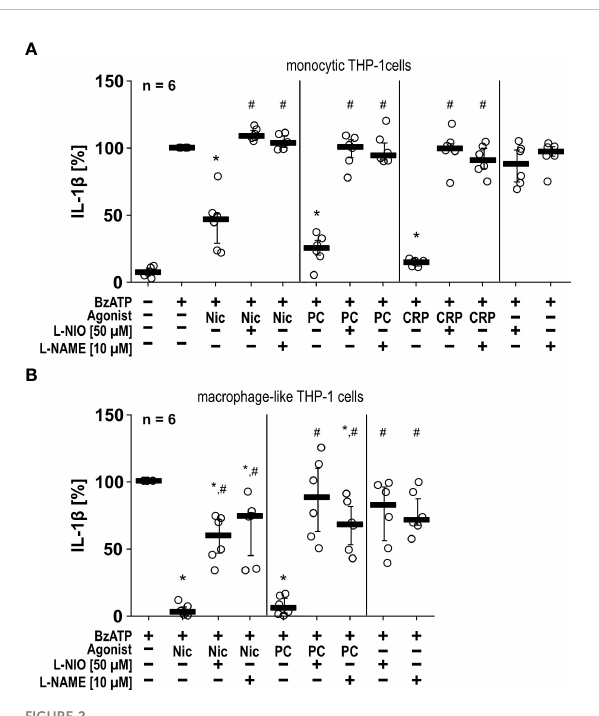
FIGURE 2 The inhibitory potential of nicotine (Nic), phosphocholine (PC) and C-reactive protein (CRP) on the BzATP-induced release of IL-1 b by human monocytic and macrophage-like THP-1 cells is reversed by nitric oxide synthase (NOS) inhibitors. Monocytic (A) and differentiated macrophage-like (B) THP-1 cells were used. Cells were primed with lipopolysaccharide (LPS; 1 µg/ml, 5 h). Thereafter, the P2X7 receptor agonist BzATP ((2 ’ /3 ’ -O-(4-benzoylbenzoyl) adenosine-5 ’ -triphosphate, tri(triethylammonium) salt) was added for another 40 min to trigger IL-1 b release, which was measured by ELISA. The inhibitory potential of Nic (100 µM), PC (200 µM) and CRP (10 µg/ml) on the BzATP-induced release of IL-1 b was investigated in absence and presence of the NOS inhibitors L-NIO (50 µM; N5-(1-iminoethyl)-L-ornithine dihydrochloride) or L-NAME (10 µM; N-omega-nitro-L-arginine methyl ester hydrochloride). (B) In experiments on macrophage-like THP-1 cells, the concentration of IL-1 b released in response to BzATP was calculated by subtracting the IL-1 b concentrations measured in supernatants of cells treated with LPS alone. In each experiment, the IL-1 b concentration obtained after stimulation with BzATP was set to 100% and all other values were calculated accordingly. Data are presented as individual data points, bars represent median, whiskers encompass the 25th to 75th percentile. *p ≤ 0.05, different from LPS-primed cells stimulated with BzATP alone; #p ≤ 0.05 signi fi cantly different from samples, in which BzATP plus agonist was given. Friedman test followed by the Wilcoxon signed-rank test. experiments in the presence or absence of nAChR agonists. While transfection of control siRNA did not impair the inhibitory effect of nicotine, PC, and CRP on the BzATP-mediated release of IL-1 b , transfection of siRNA speci fi c for NOS3 blunted the inhibitory effect (Figure 3A).